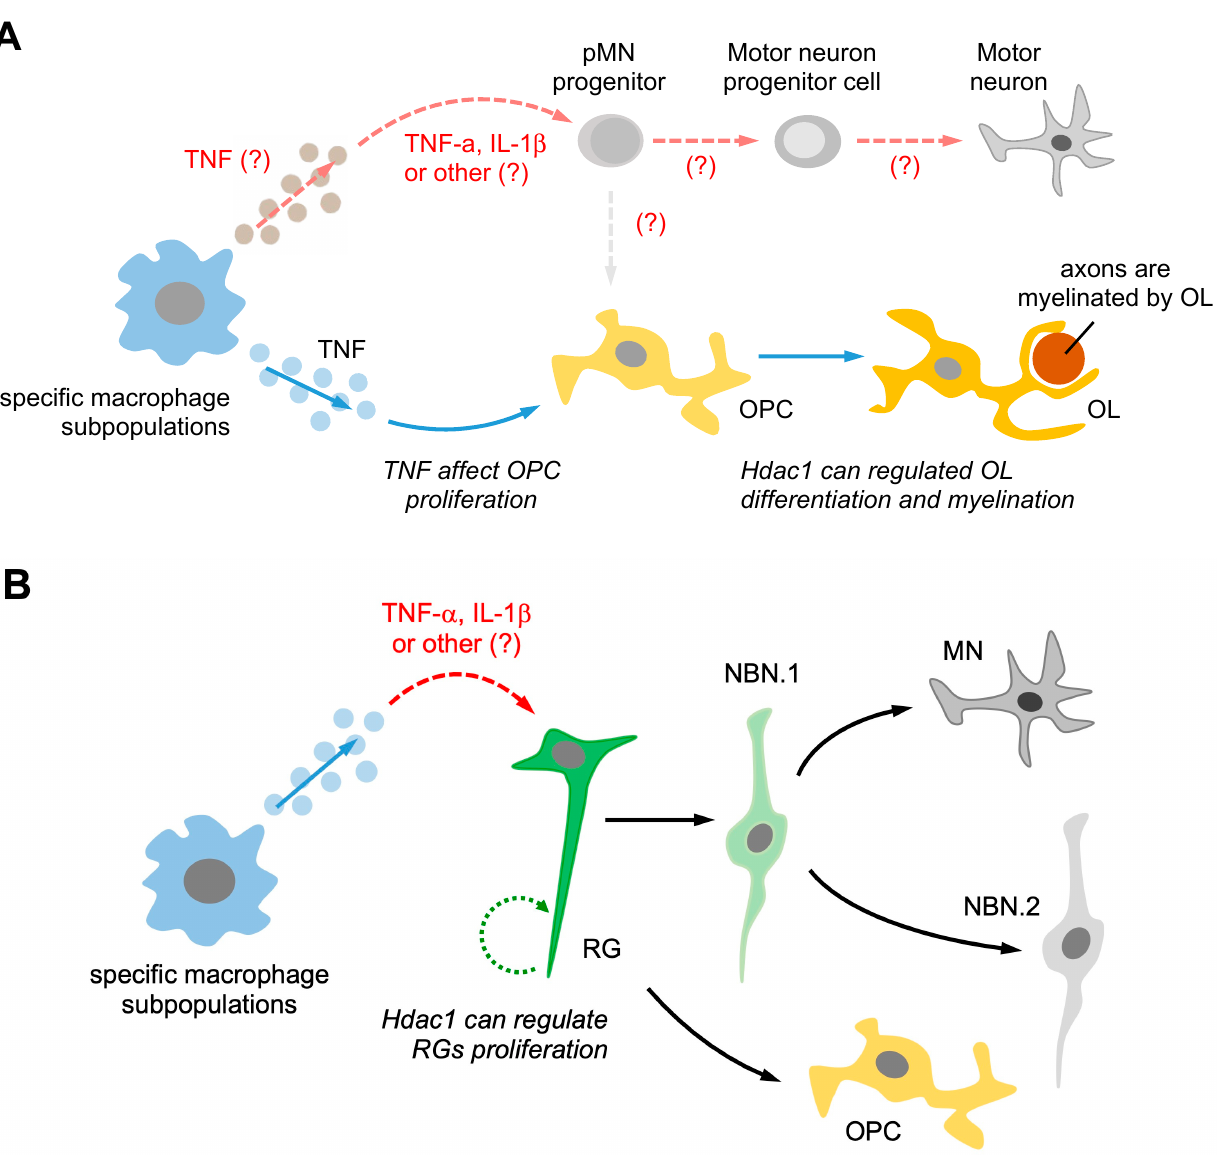
Figure 3. Pro-regenerative macrophages may activate different types of neuroglia, which can promote neurogenesis through an extrinsic signaling pathway. ( A ) Pro-regenerative macrophages utilize two different signaling pathways to induce pMN progenitors and oligodendrocyte progenitor cells (OPCs) to promote regenerative neurogenesis. Firstly, macrophage-secreted TNF- α may induce pMN progenitors, promoting neurogenesis instead of generating OPCs. Secondly, macrophage-secreted TNF- α can affect OPC proliferation and increase the Hdac1-mediated pathway, promoting oligodendrocyte (OL) differentiation and myelination. ( B ) The subpopulation of macrophages can secrete TNF- α , which directly induces the Hdac1-mediated pathway in radial glial cell (RG) activation, leading to RG proliferation. TNF- α secreted by macrophages may also guide RGs towards the neurogenesis pathway, promoting the generation of motor neurons (MNs) instead of NBN. The differentiation of RG into neurons is known as the neurogenesis pathway, while differ- entiation into OPCs is referred to as the gliogenesis pathway. The “(?)” symbol indicates questions that require further investigation in the future.